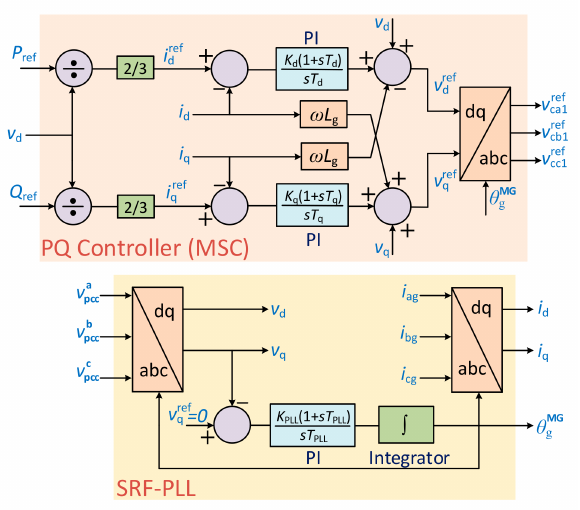
Figure 5. Block diagram of PQ controller for